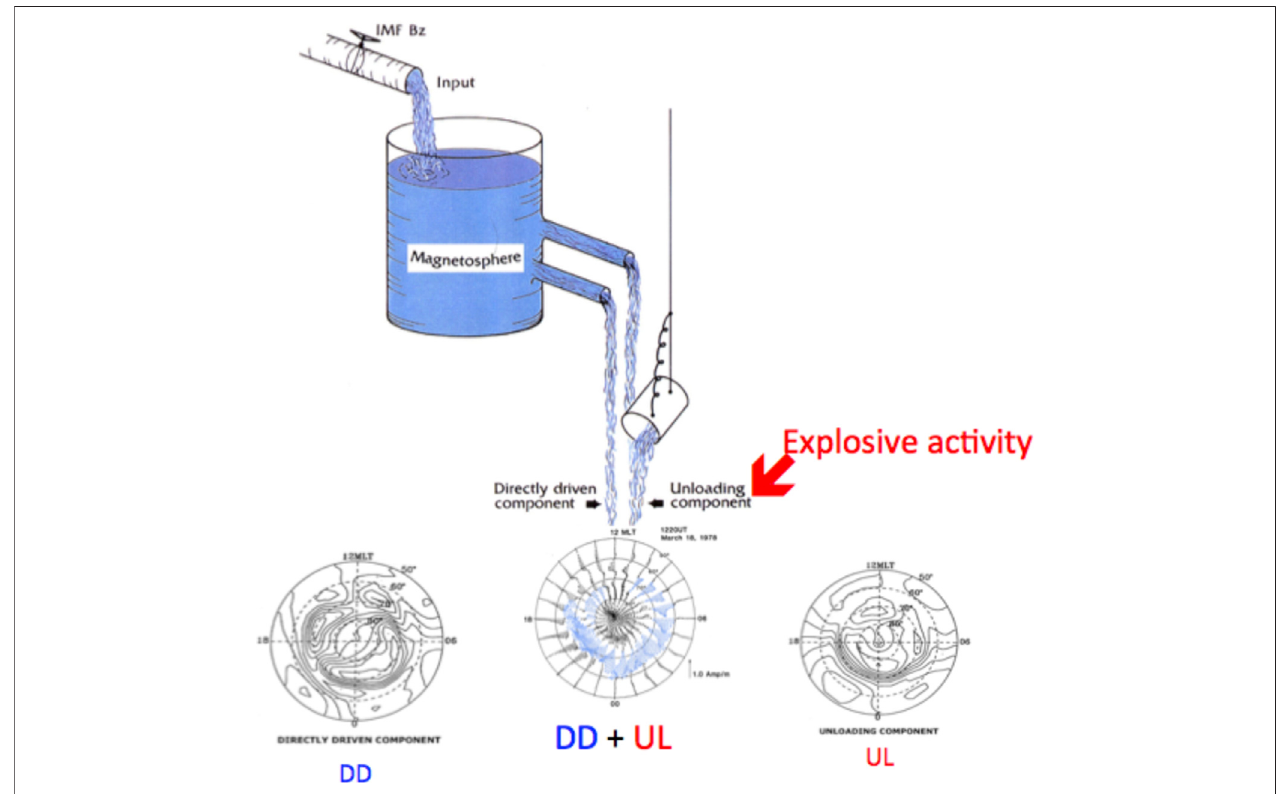
FIGURE14| Thetank-tippypitcher model. What wecanobservebyaground-based magnetometernetwork is(DD+UL). The fi gure shows also both theDDand UL components.